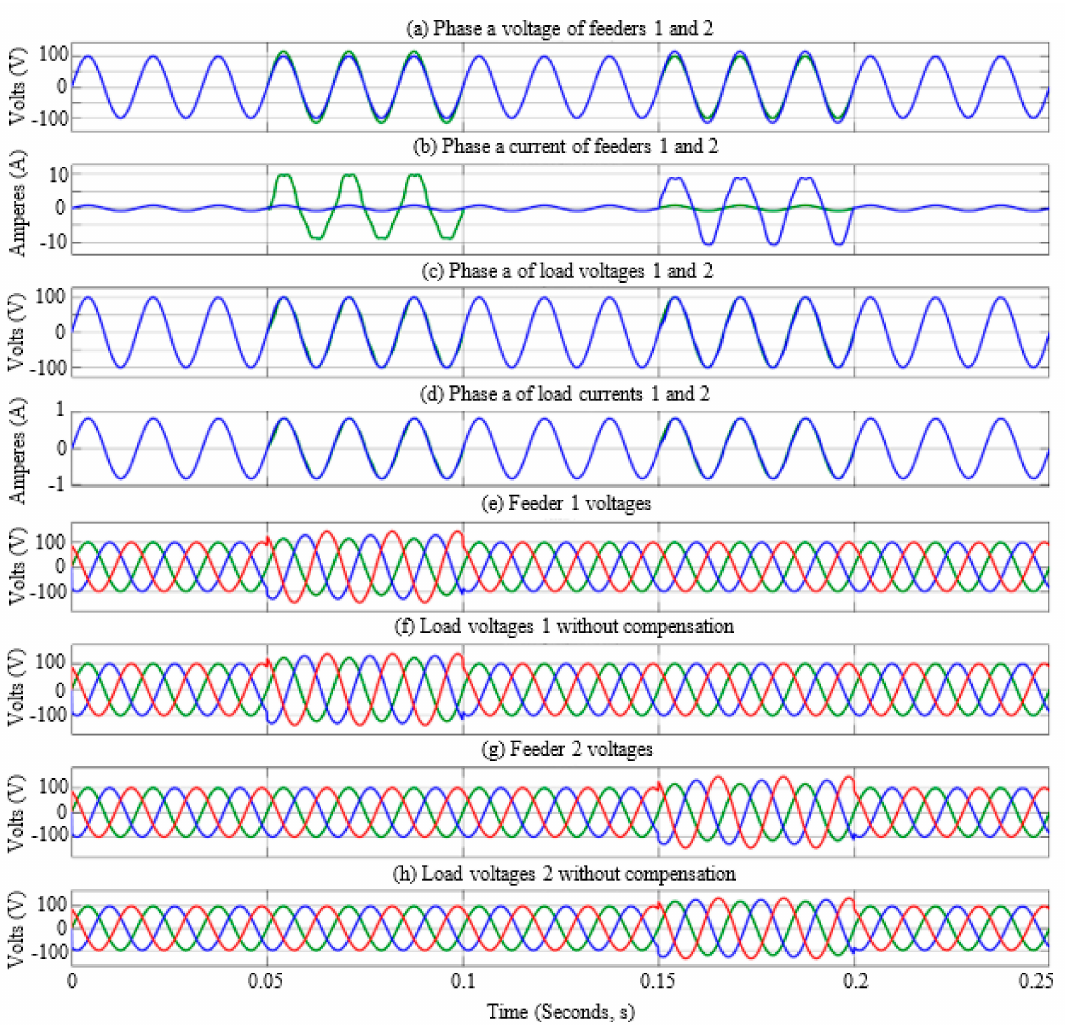
Figure 14. System waveforms in the unbalanced voltage swell compensation. ( a – d ) System phase a waveforms; ( e – h ) system waveforms without a